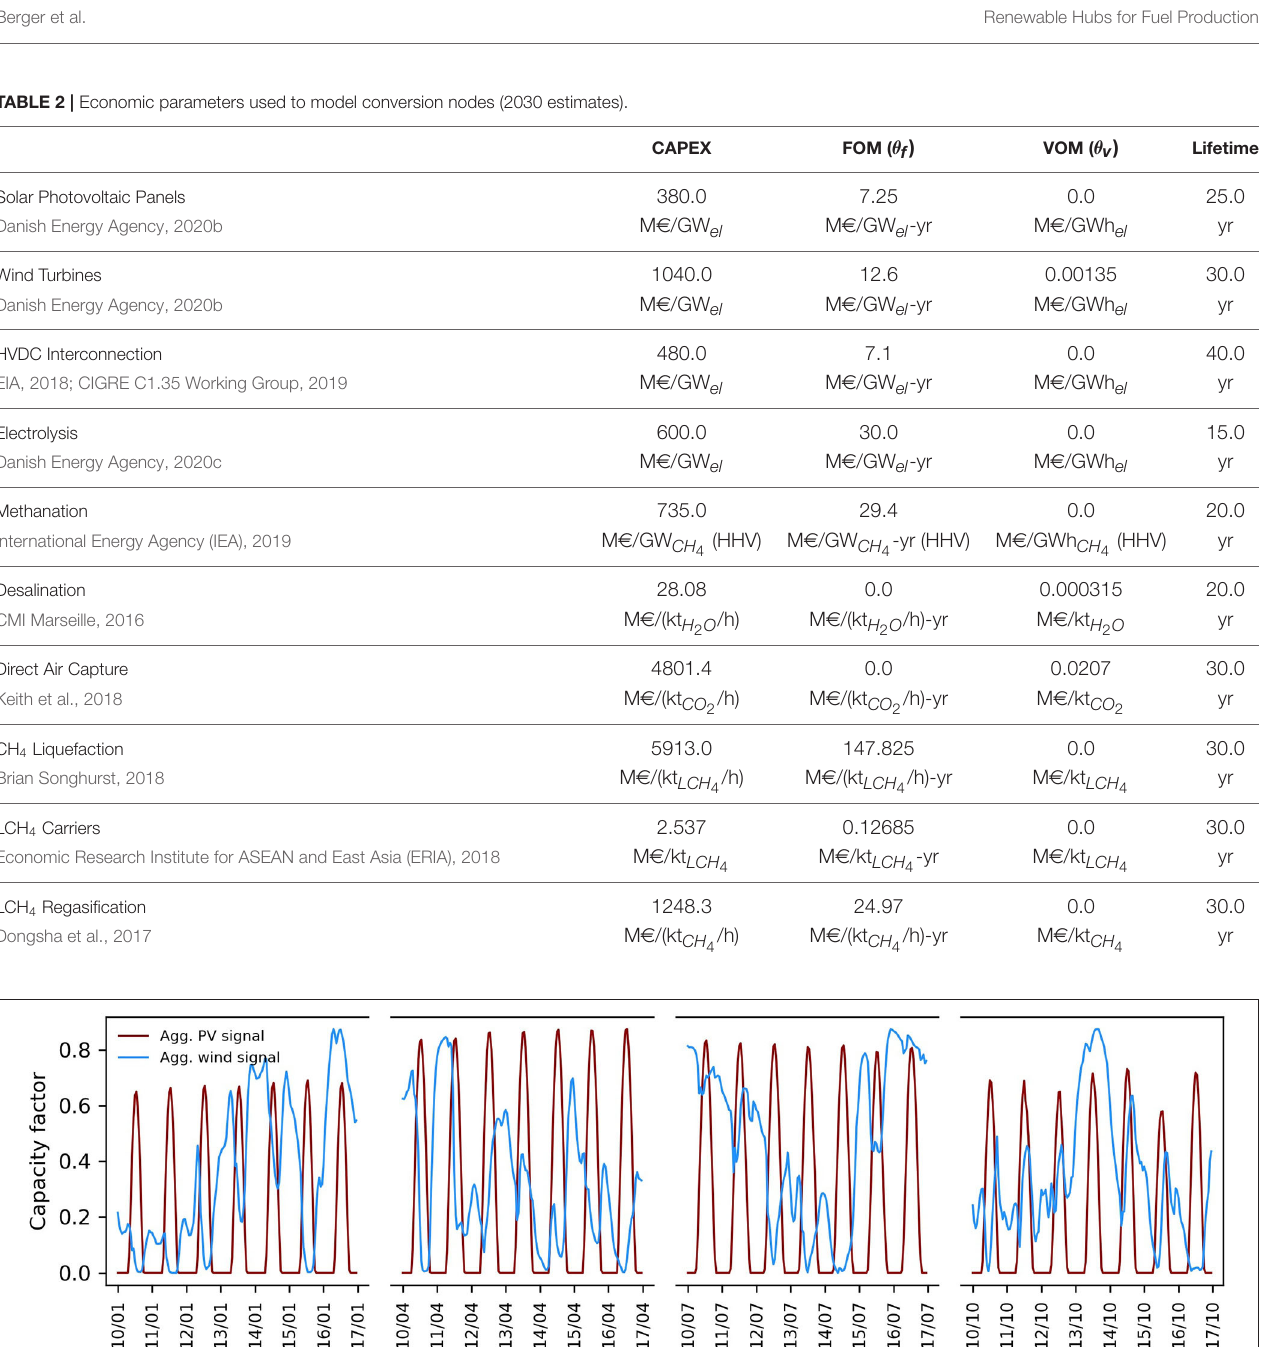
FIGURE 4 | Capacity factor time series π n t used for solar PV and wind power plants in 2016. For all other nodes except liquefied methane carriers, π n t = 1 over the entire time